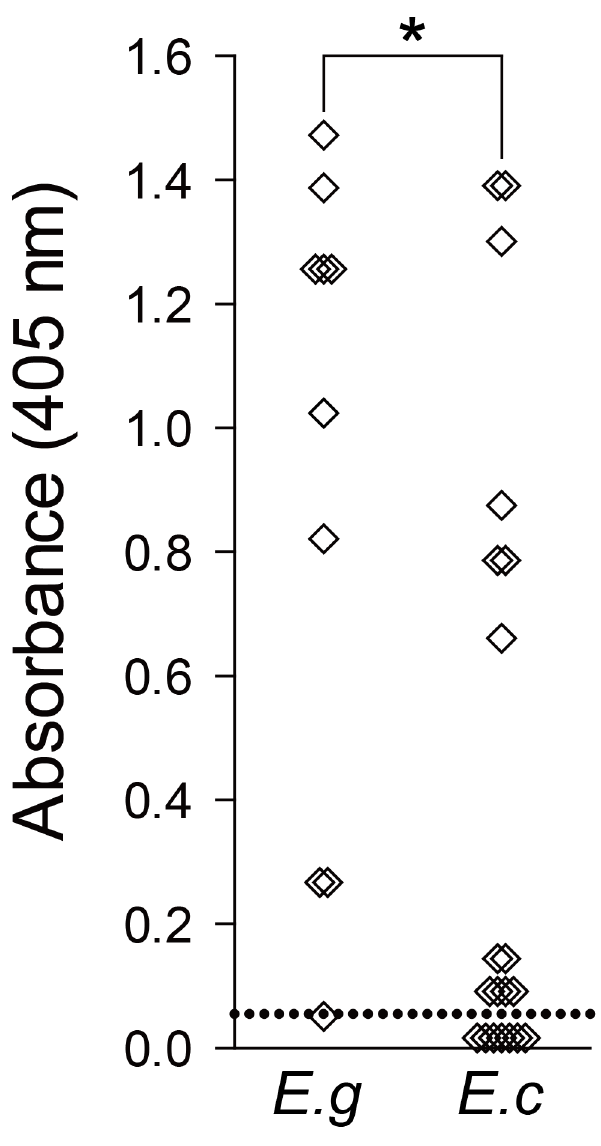
Figure 3. Results of ELISA with rEmAgB for CE cases infected with E.granulosus s.s. (G1) (n = 10) and E.canadensis (G6/7) (n = 20). The cut-off OD value was 0.055, and was indicated by the dotted line. E.g :: E. granulosus s.s. (G1) case serum samples, E.c .: E. canadensis (G6/7) case serum samples. *: p = 0.0137